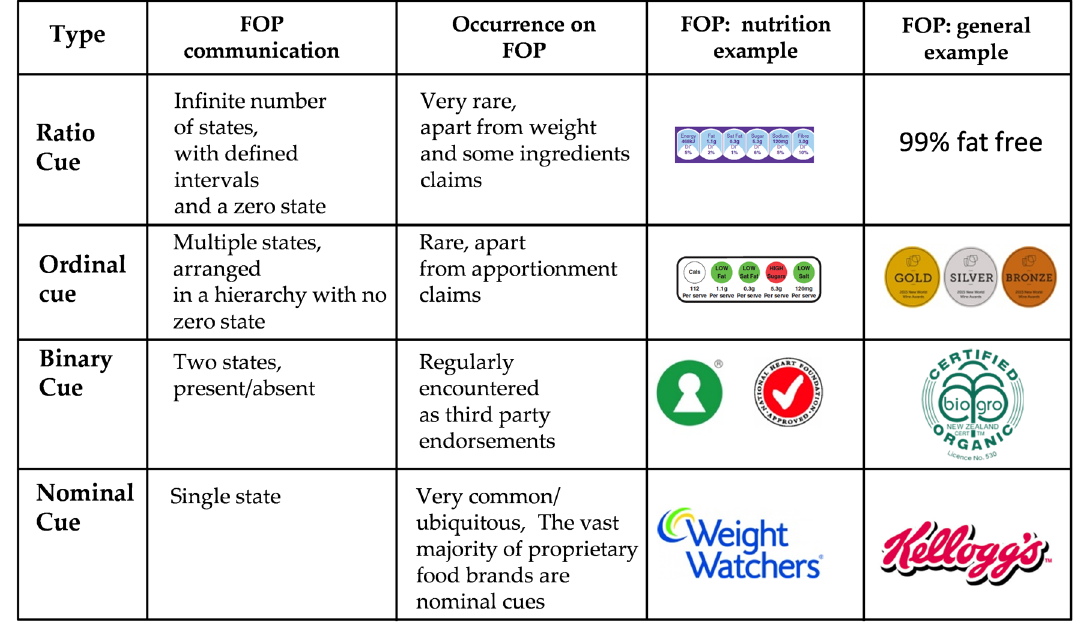
Figure 8. Nominal, binary, ordinal and ratio cues.